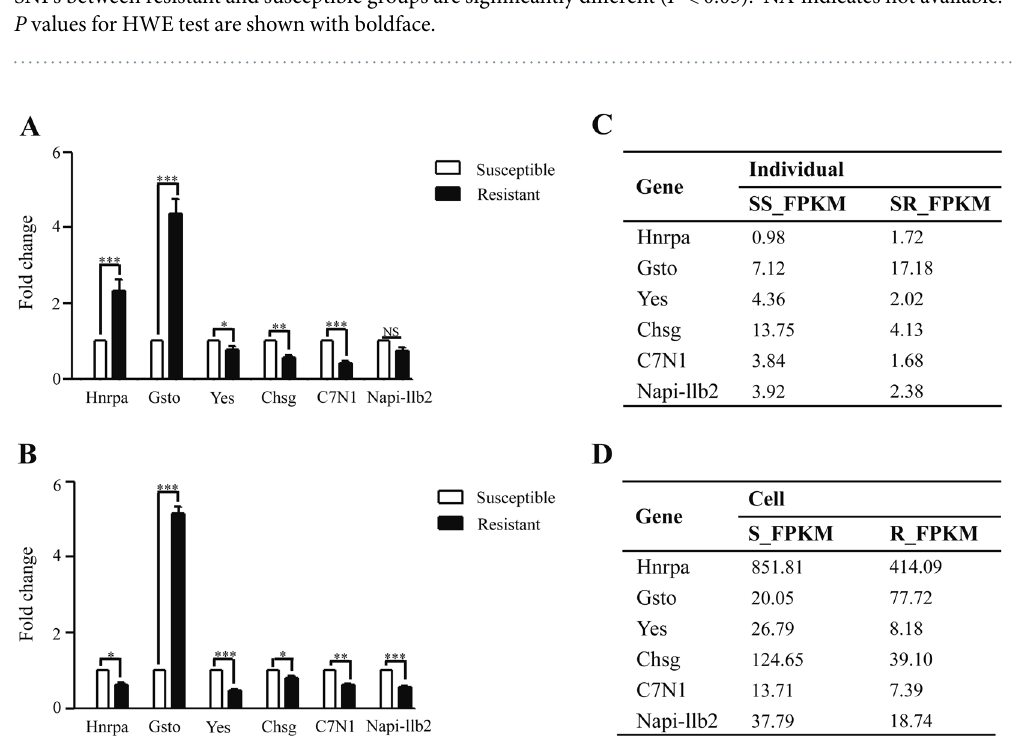
Figure 7. mRNA expression profiles in spleen tissue and CIK cells. Transcripts of 6 genes with more than one genotype in 9 genes with confirmed SNPs were quantified in resistant and susceptible groups in spleen ( A ) and CIK ( B ) by qRT-PCR (n = 3). 18 S rRNA and EF1 α as reference genes were used in individuals and cells respectively. Fold changes of mRNA expressions were relative to corresponding susceptible samples (defined as 1). FPKM values of corresponding genes in RNA-Seq datasets of spleen and CIK were demonstrated in ( C ) and ( D ),